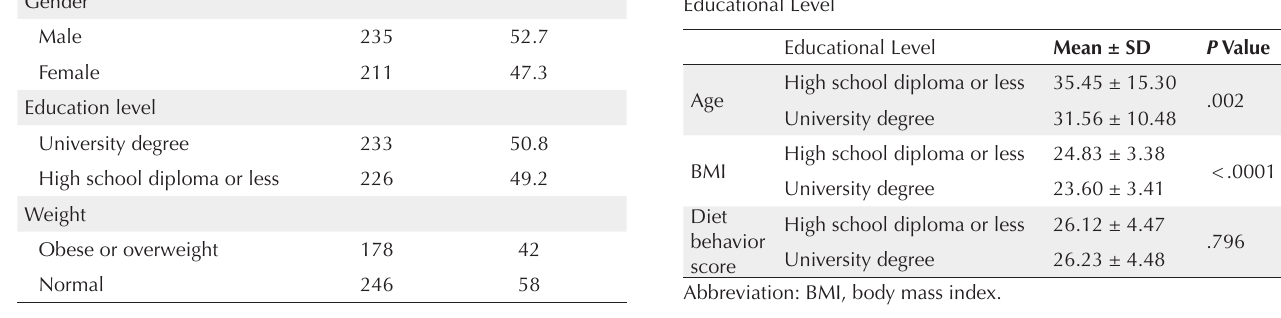
Table 4. Comparison of Age, BMI and Diet Behavior Score